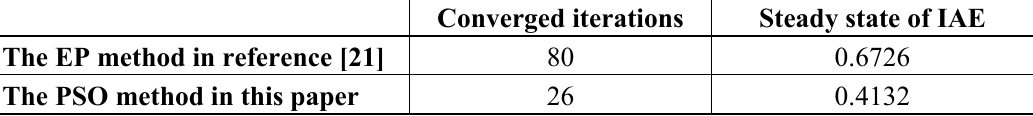
Table 2. The convergence situation of PSO vs . EP with the initial conditions